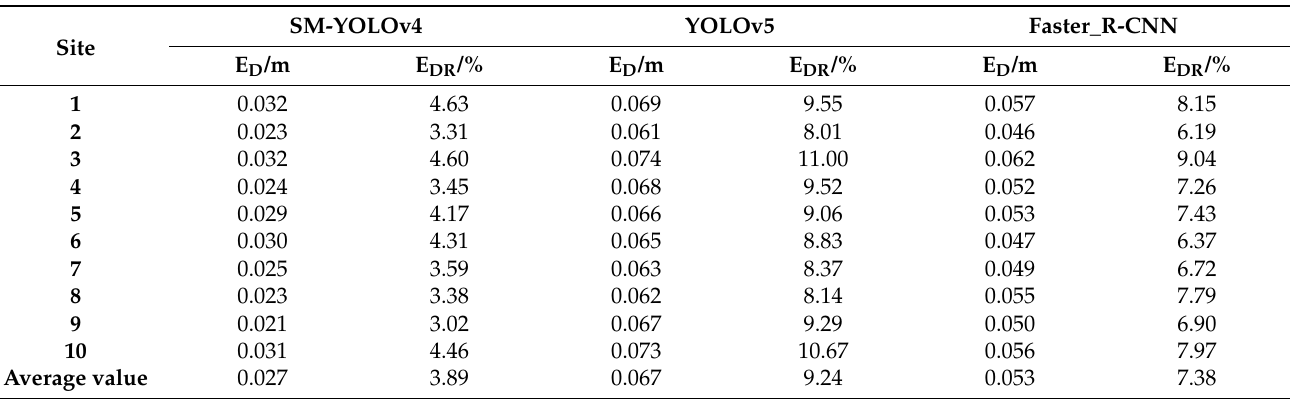
Table 4. Grape bunch pre-positioning